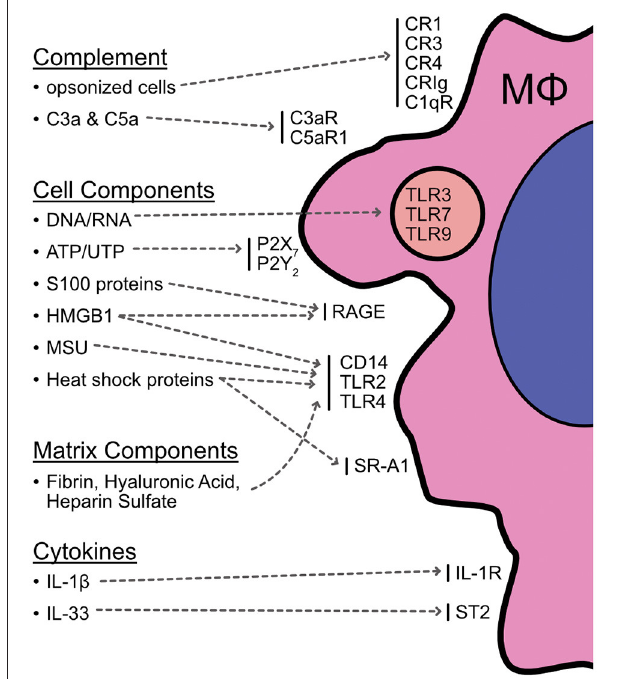
FIGURE 1 | Summary of potential interactions between macrophages and cell death. Macrophages express a variety of machinery for detecting cell death and products released from cells or the surrounding matrix as a result of necrotic death. These include receptors for complement opsonized cells (CR1, CR3, CR4, CRIg, C1qR); complement cascade components (C3aR, C5aR); DNA/RNA (endosomal TLRs 3, 7, & 9); purines (P2X 7 , P2Y 2 ); monosodium urate (CD14/TLRs); S100 proteins (RAGE); HMGB1 (RAGE, TLRs); heat shock proteins (TLRs, SR-A1); the matrix components fibrin, hyaluronic acid, and heparin sulfate (TLRs); and cytokine alarmins such as IL-1 β and IL-33 (IL-1R, ST2). This list is not exhaustive and additional interactions are continuously being described and investigated. It is still unclear to what extent these interactions are involved in AKI and if macrophage stimulation is a critical element for bridging injury and pathogenic inflammation, but it is clear there are multiple avenues for macrophages to engage with cell death events in a tissue